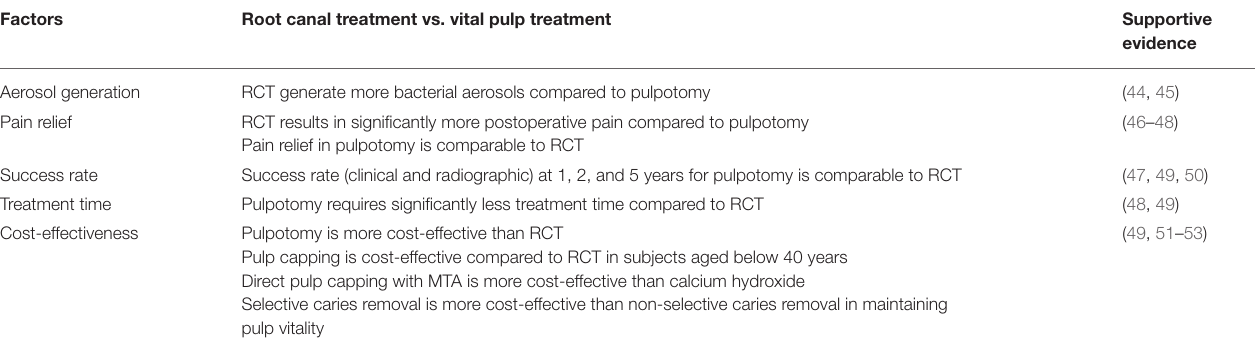
TABLE 2 | Comparative analysis of clinical and patient related factor for root canal treatment and vital pulp treatment in permanent teeth.